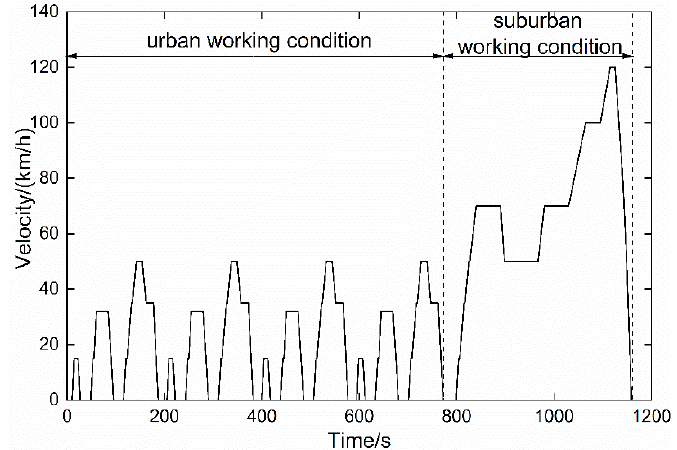
Figure 13. New European drive cycle (NEDC) working conditions.